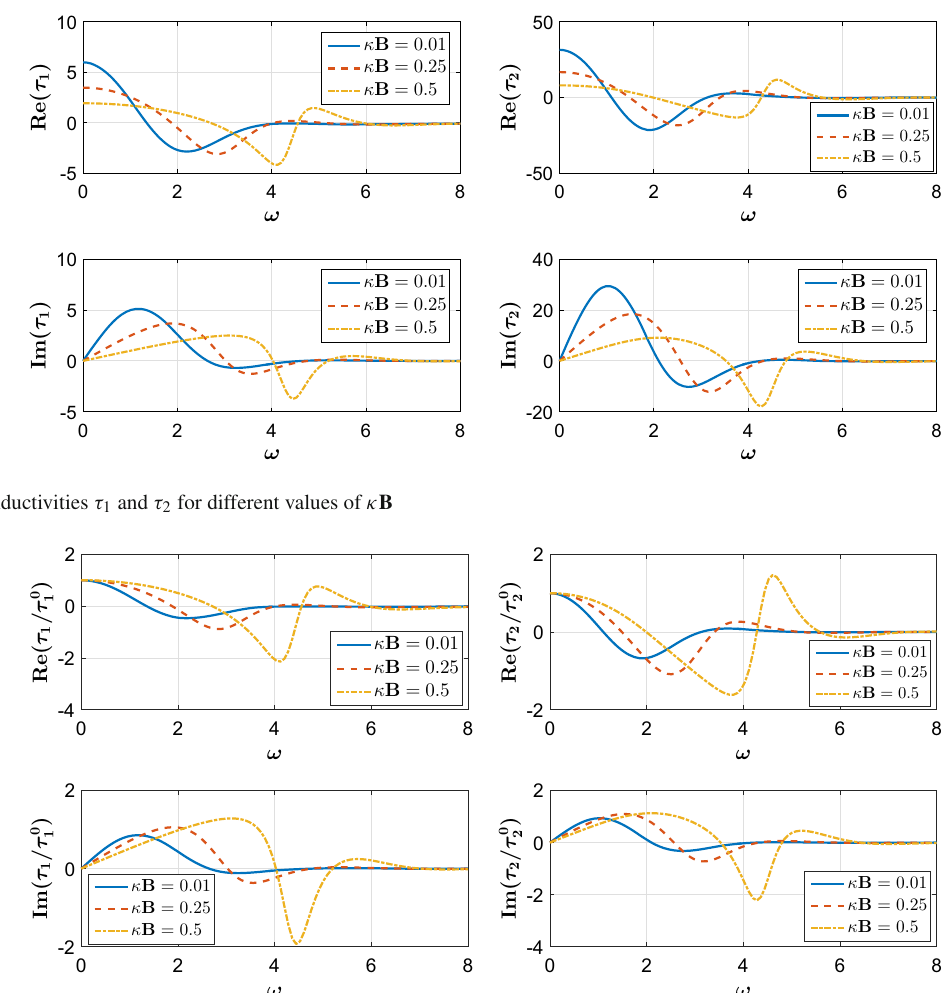
/ 5, τ 1 , τ 0 , and Re 1 2 1